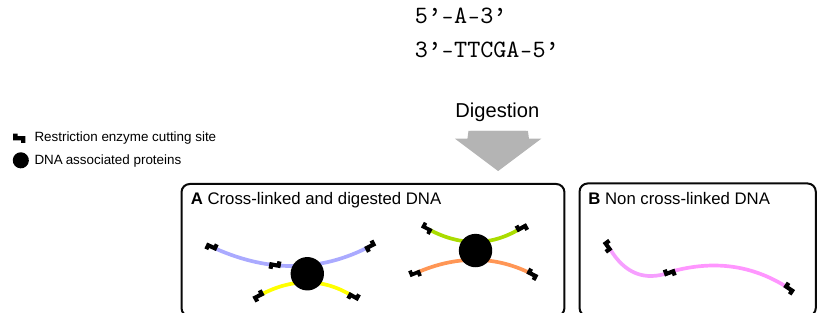
Figure 1. The restriction digestion of cross-linked chromatin results in fragments, also referred to as digests, whose ends correspond to restriction cutting sites of the chosen enzyme (step-like